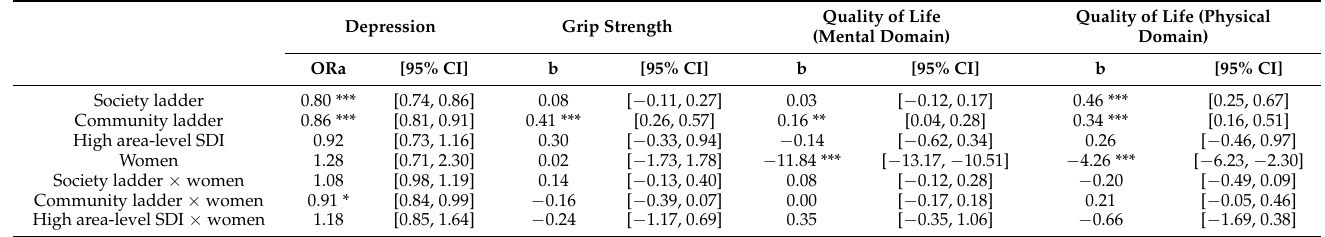
Table 3. Associations between perceived social status, area deprivation, and sex differences in health